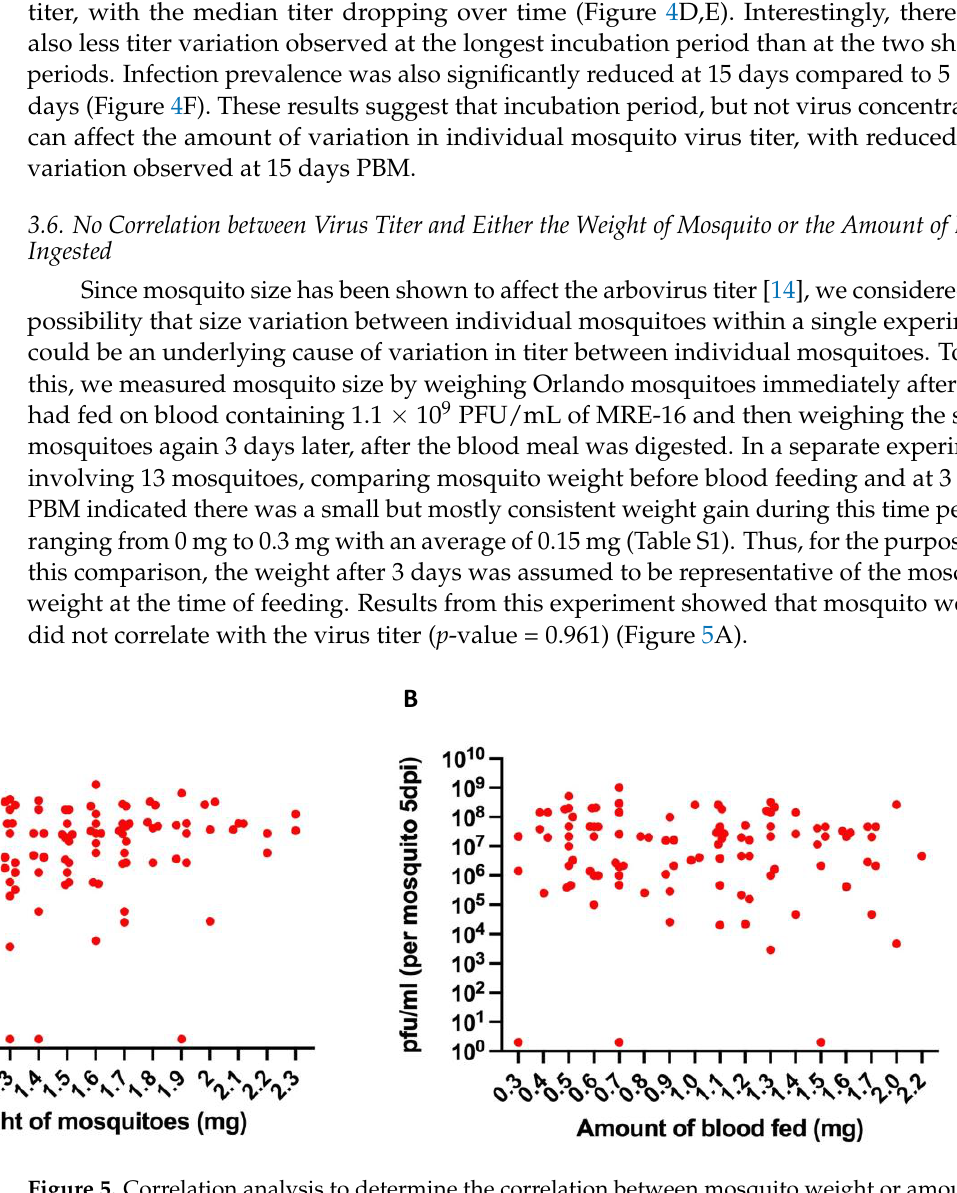
Figure 5. Correlation analysis to determine the correlation between mosquito weight or amount of blood fed and virus titer at 5 d PBM. ( A ) Correlation analysis of mosquito weight and virus titer. ( B ) Correlation analysis of amount of blood ingested and virus titer. Sample size used was 100. Pearson’s correlation chi square test was used for the statistical analysis.